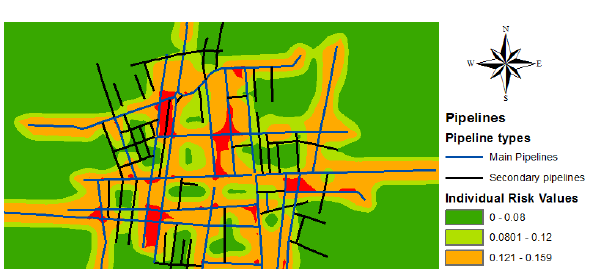
Figure 6 Individual Risk Map for Fireball